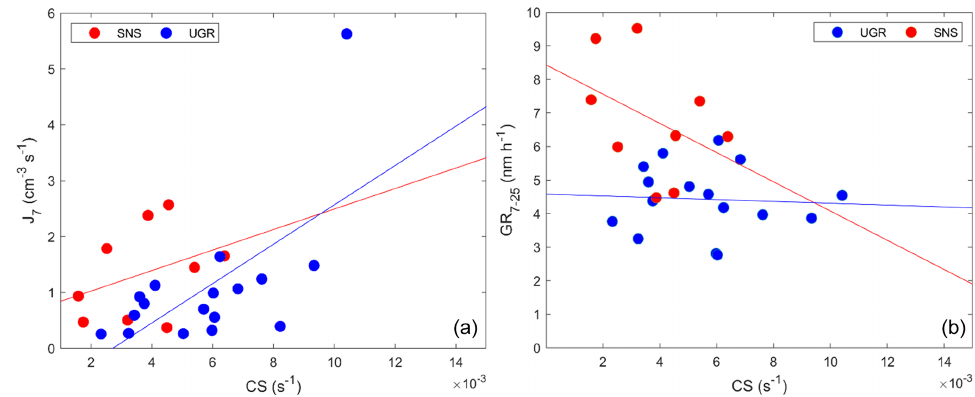
Figure 7. Relationship between CS (time window: 09:00–16:00UTC) and J 7 (a) and GR 7 − 25 (b) during the study period.